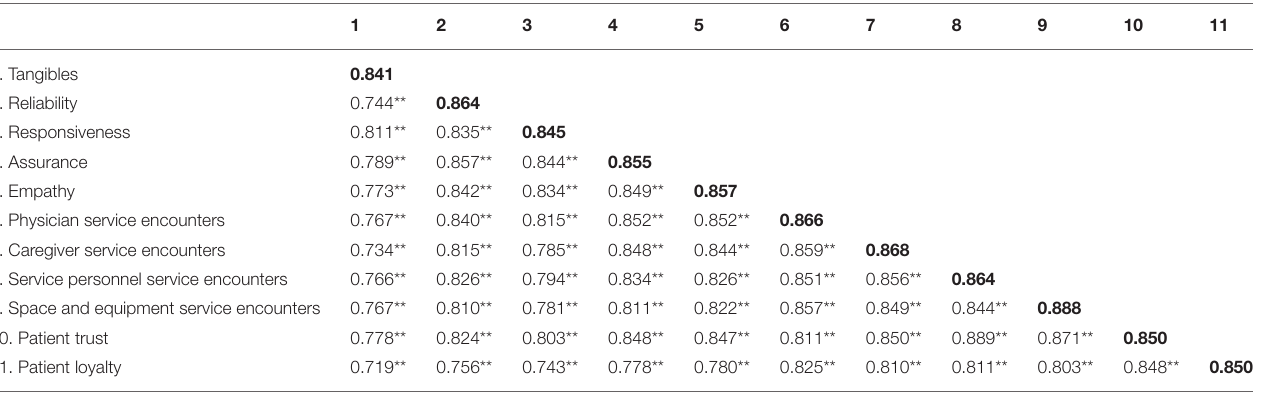
TABLE 6 | Correlation analysis ( n =